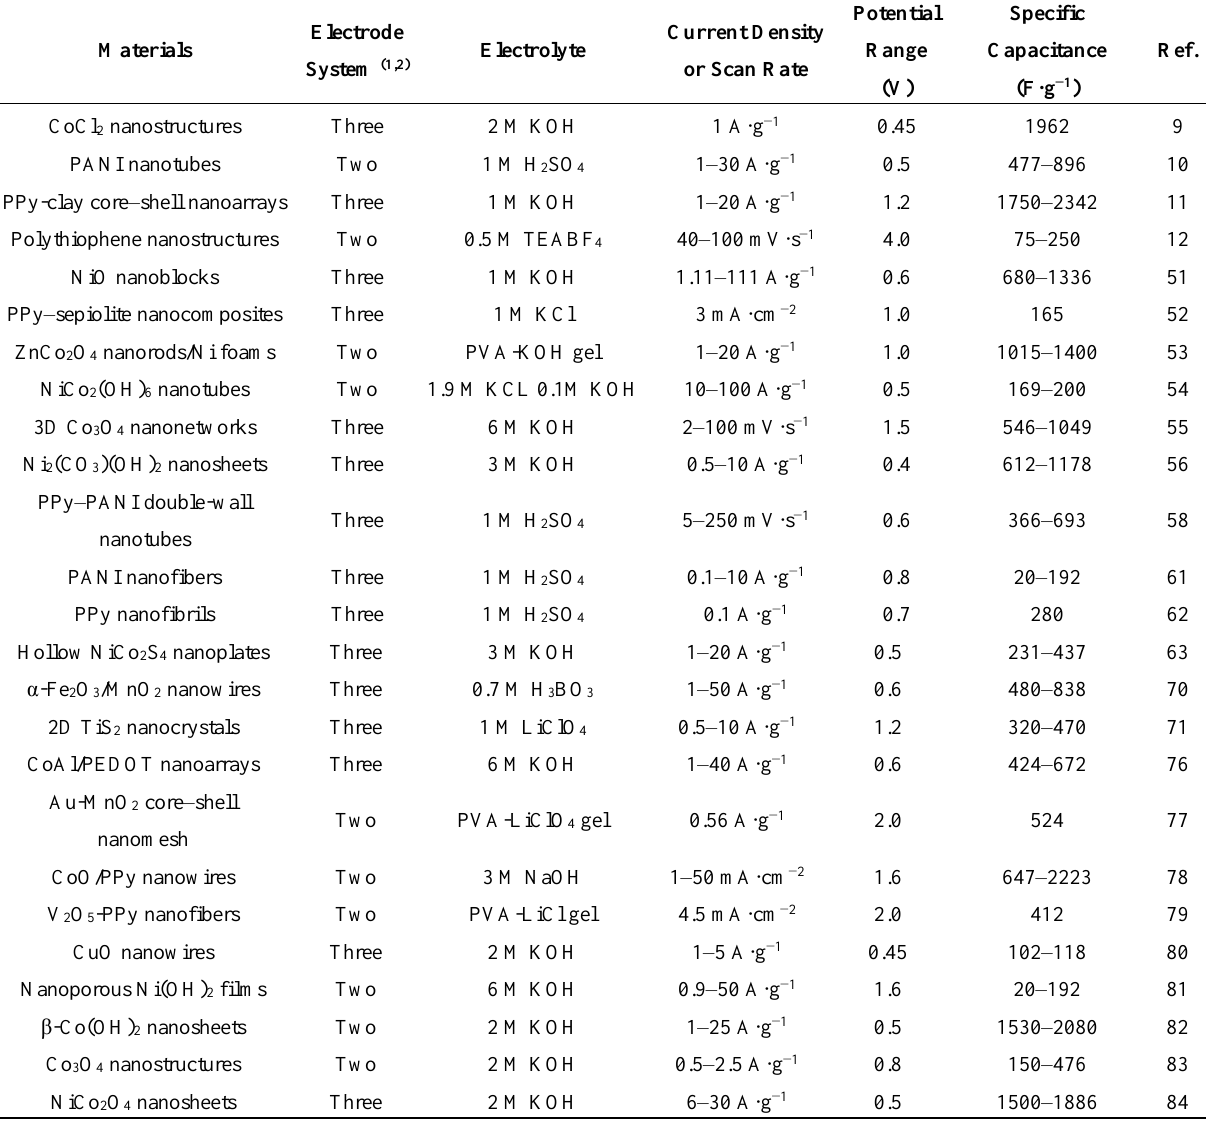
Table 2. Pseudocapacitor materials and electrochemical